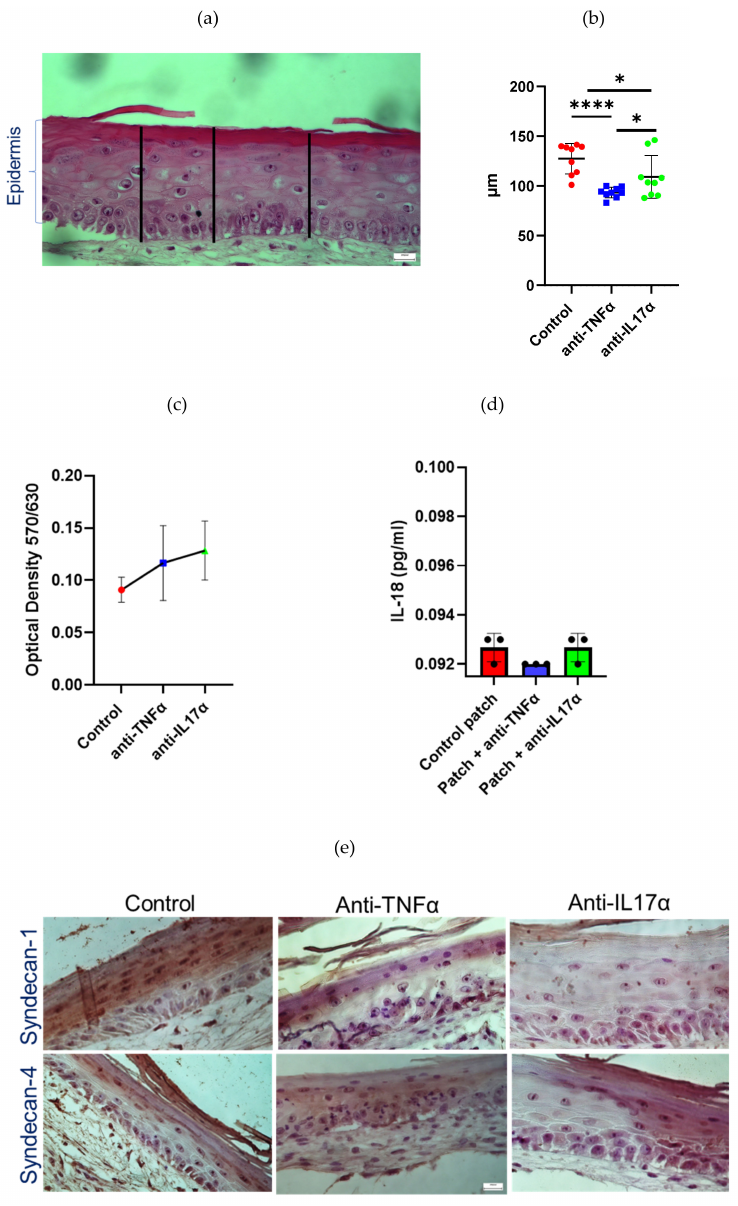
Figure 5. Effects of anti-TNF α and anti-IL-17 α topical treatments onto the Phenion full-thickness skin model. H and E and immunohistological analysis of TNF α and IL17 α blockers—treated SEs demon- strate reduction of epidermal thickness, accelerated differentiation process and altered syndecan-1 and -4 expression/distribution. ( a ) Epidermal thickness was assessed at regular intervals across the sections using ImageJ. ( b ) Mean epidermal thickness in microns. Three images corresponding to three independent experiments were analyzed per condition. Mean ± SD, t-student test for the comparison of two groups or multiple t-tests for more, * p < 0.05, **** p < 0.0001. ( c ) The biocompatibility was assayed using MTT proliferation analysis against control which was application of gelatin patch without blockers. ( d ) Contact sensitivity was assayed by analyzing IL-18 quantity (pg/mL) in the culture supernatant by ELISA at the same experimental conditions. ( e ) Evaluation of biological factors—enhanced gelatin patches using full-thickness reconstructed skin models. Immunohistologi- cal detection of syndecan-1 and -4 in reconstructed skin models after application of gelatin patches containing anti-TNF α or anti-IL17 α